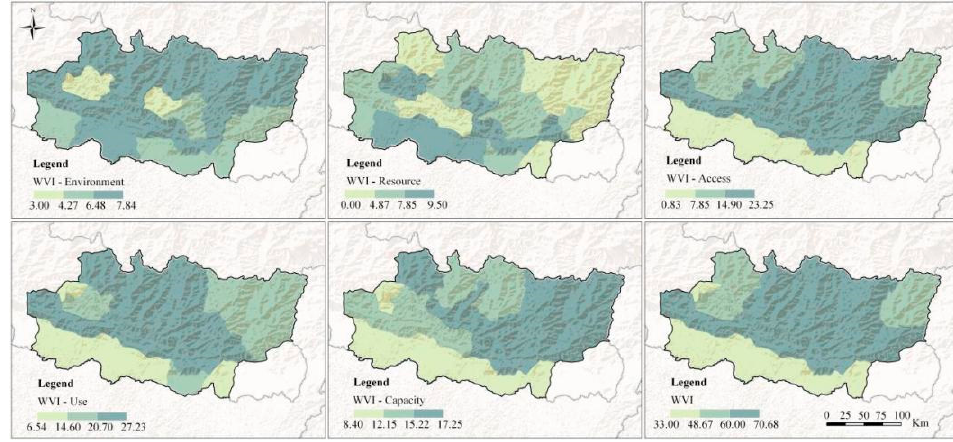
Figure 4. The spatial distribution of the WVI and the component